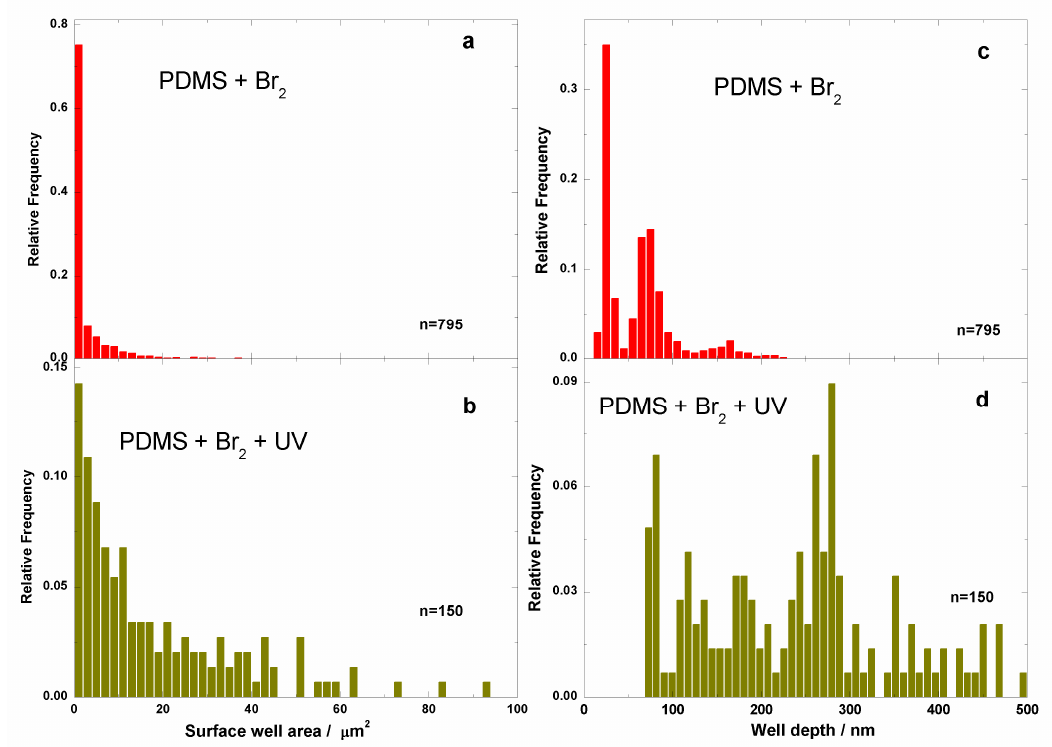
Figure 9. Well surface area histograms for bromine-treated samples: ( a ) PDMS + Br 2 composite, and ( b ) PDMS + Br 2 + UV composite. The well depth histogram for bromide-treated sample: ( c ) PDMS + Br 2 composite, and ( d ) PDMS + Br 2 + UV. Here, n is the number of wells detected in the 12 AFM images used to produce the histograms.